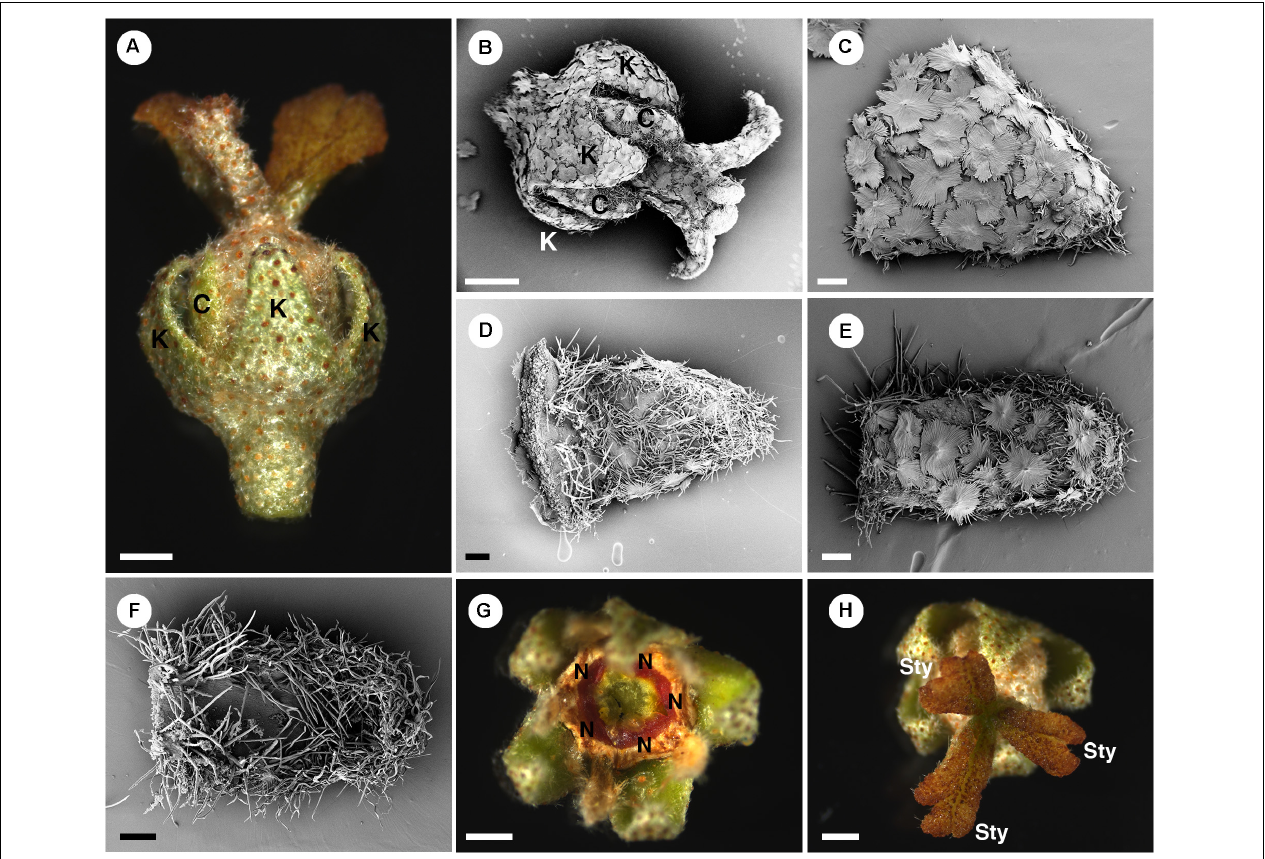
FIGURE 8 | Morphology of pistillate flowers of Croton alabamensis . (A) A flower near anthesis. Fully developed petals are present. Styles are bilobed but do not fork. (B) A flower near anthesis with visible sepals and petals. Styles are slightly bifid in this flower. Note outer surface of all organs is covered with lepidote trichomes. (C) Abaxial side of a sepal covered with lepidote trichomes. (D) Adaxial side of a sepal. There are many stellate trichomes covering the surface. (E) Abaxial side of a petal covered with lepidote and stellate-lepidote trichomes. (F) Adaxial side of a petal. The margin is densely covered with simple trichomes. (G) A nectary ring inside the corolla initially with yellow color that later changes to red. (H) Three styles and stigmatic surfaces. Note, stigmatic lobe number vary from two to four. K, sepal; C, petal; N, nectary; Sty, style. Scale bars: (A,B,G,H) = 1,000 µ m; (C–F) = 200 µ